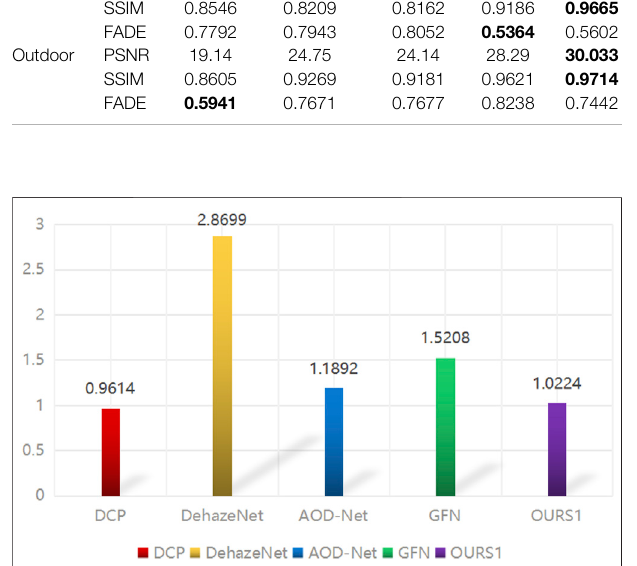
Frontiers in Physics |